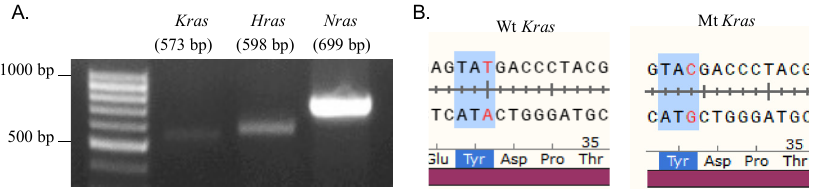
Figure 4. Sequencing of RAS family genes in N2A cells. ( A ). The PCR product of Kras , Hras , and Nras was detected by agarose. ( B ) The sequence of Kras gene from NCBI database (Wt Kras ) and N2A cells (Mt Kras ). Mt Kras harbors a synonymous mutation: c.96T>C (p.32Y=). Table 1. RAS Sequencing results of N2A cells. Gene Sequencing Results Kras Synonymous mutations, c.T96>C Hras No mutation Nras No